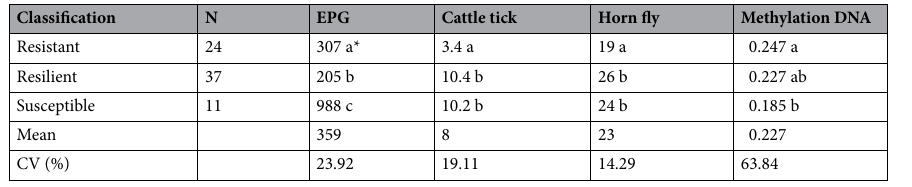
Table 2. Average number of eggs per gram of feces (EPG), Rhipicephalus microplus (cattle tick), Haematobia irritans (horn fly), global DNA methylation quantification (absolute absorbance value), and number of heifers per group (N) distributed into resistant, resilient, and susceptible groups, by GENES program. *Different letters in the column show significant differences between groups by the Tukey’s test ( p <